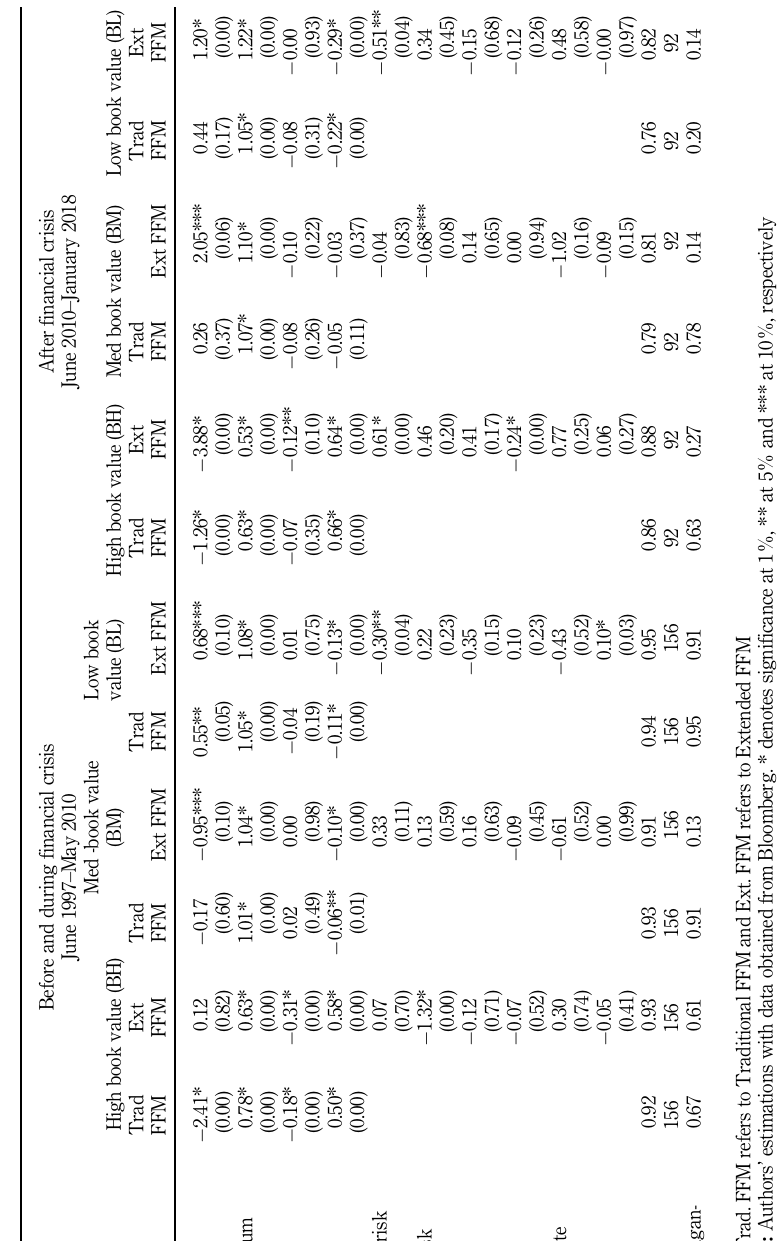
Table 6. Results portfolio